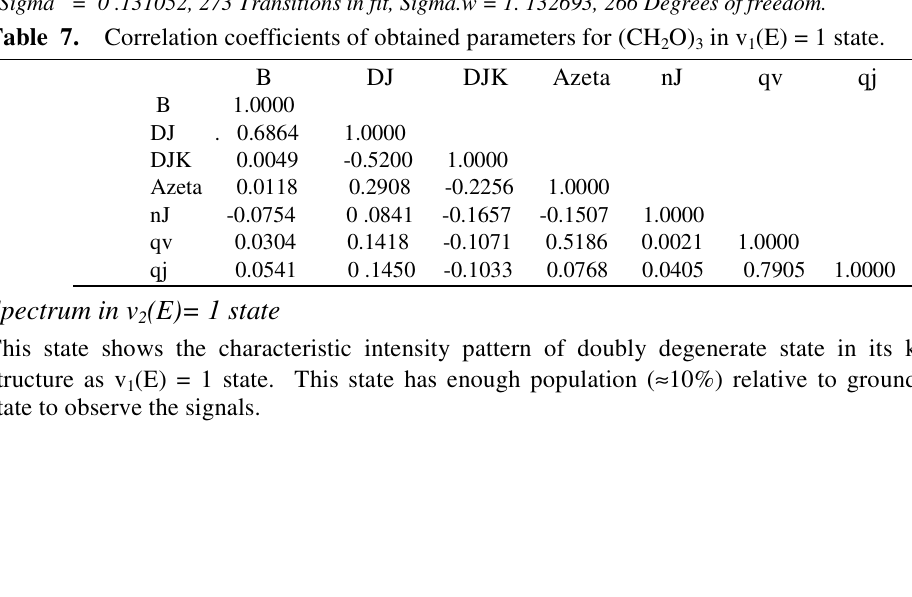
Correlation coefficients of obtained parameters for (CH